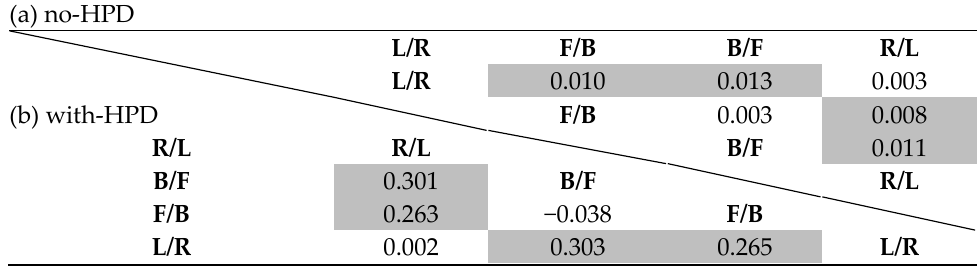
Table 5. Post hoc LSD analyses between hemifields under (a) no-HPD and (b) HPD conditions.